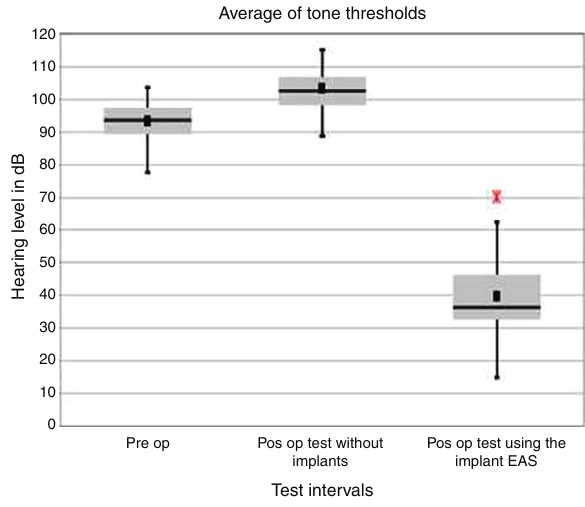
Average pure tone audiometric thresholds (500 Hz, 1 kHz, 2 kHz, 3 kHz): comparison among preoperative tests, last postoperative test without use of a hearing aid, and last test using the implant (EAS) (hearing level in dB) ( n = 19). Mean val- ues are shown as vertical black lines, medians as horizontal lines. Red asterisk represents outliers.